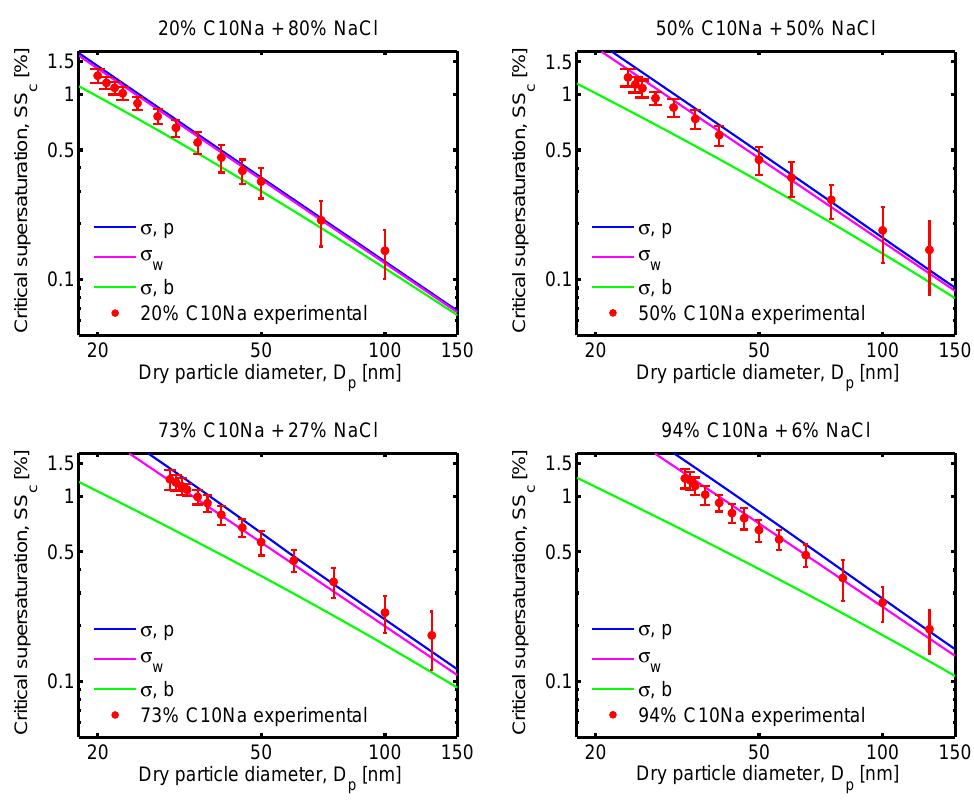
Fig. 3. Critical supersaturations ( SS c [ % ] ) as functions of dry particle diameter ( D p [nm]) for particles with sodium decanoate (C10Na) in dry mass fractions ( W p, C10Na ) of (a) 20%, (b) 50%, (c) 73%, and (d) 94%, measured in experiments and modeled with the three different surfactant representations ( σ,p , σ,b , and σ w